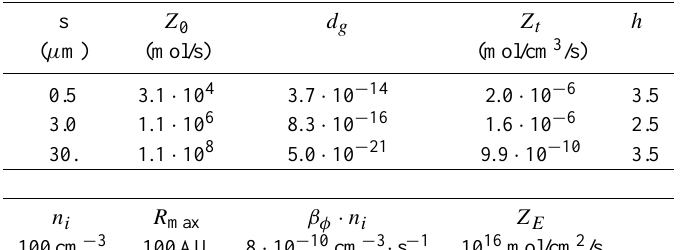
Table 1. Production rates for different grain mantle